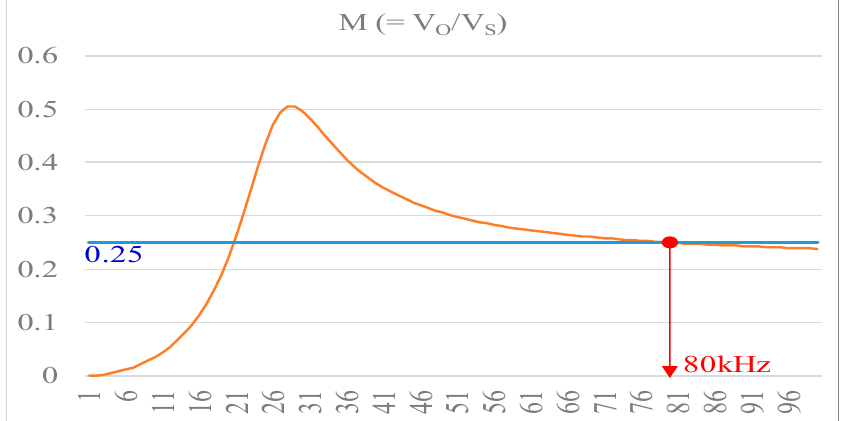
Figure 4. Voltage gain (M) of the proposed tripler and quadrupler rectifiers. In the quadrupler rectifier, since the voltages (V D and V NS1 ) on C D and secondary turns (N S1 ) are V O /2 and V O /4 during 0.5 T S of the undot direction operation, as shown in Figure 2c, the voltage (V M ) on the magnetizing inductor (L M ) is nV O /4; thus, i LM , Max is nV O /(16 · L M · F S ).